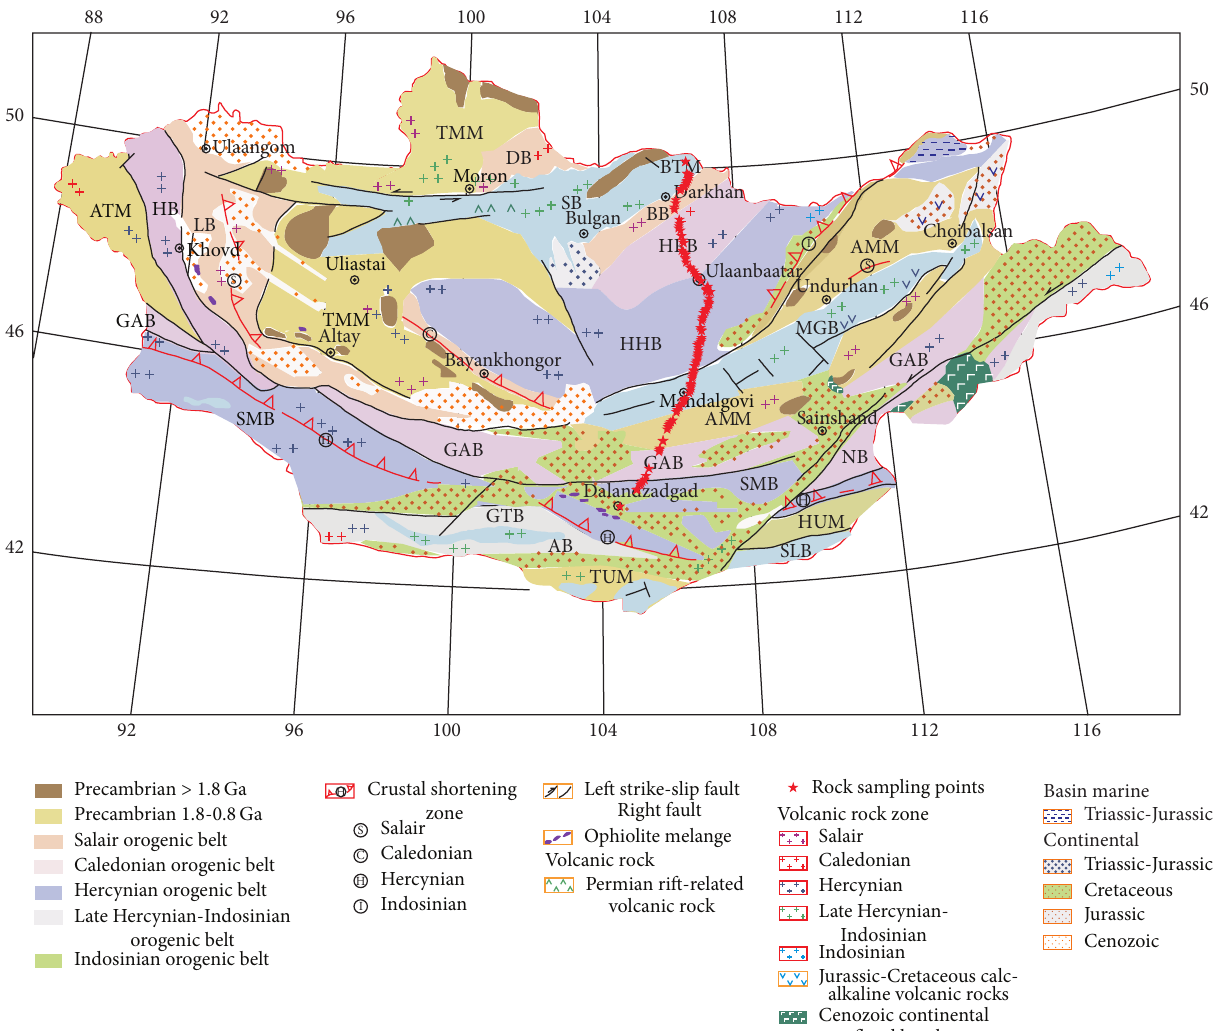
Figure 1: Outline of tectonic map of Mongolia with the sampling points of rock samples along the Suhbaatar-Ulaanbaatar-Dalandzadgad geophysical profile (compiled after Wang et al. [13]). Tectonic Units . North Mongolia: Tuva-Mongolian Massif (TMM); Argun-Mongolian Massif (AMM); Altai-Mongolian Massif (ATM); Buteel Massif (BTM); Lake belt (LB); Bayangol belt (BB); Dzhida belt (DB); Haraa belt (HRB); Gobi-Altai-Mandalgovi belt (GAB); Hangai-Hentii belt (HHB); Selenge belt (SB); Middle Gobi belt (MGB). South Mongolia: Tsagaan Uul Massif (TUM); Hutag Uul Massif (HUM); Nuhetdavaa belt (NB); Gobi-Tienshan belt (GTB); South Mongol belt (SMB); Atas Bogd belt (AB); Sulinheer belt